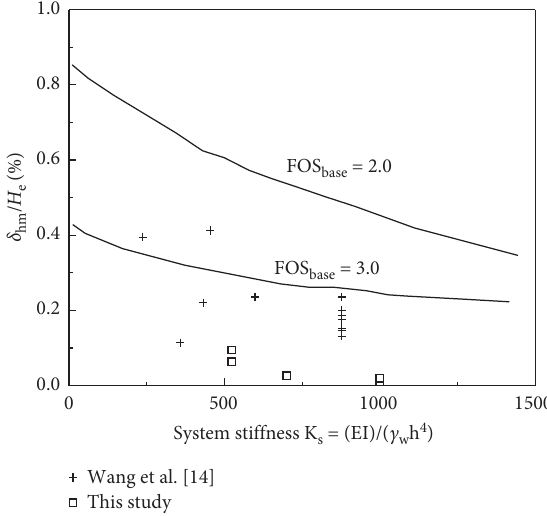
Figure 14: Relationship between the normalized maximum de- flection and the system